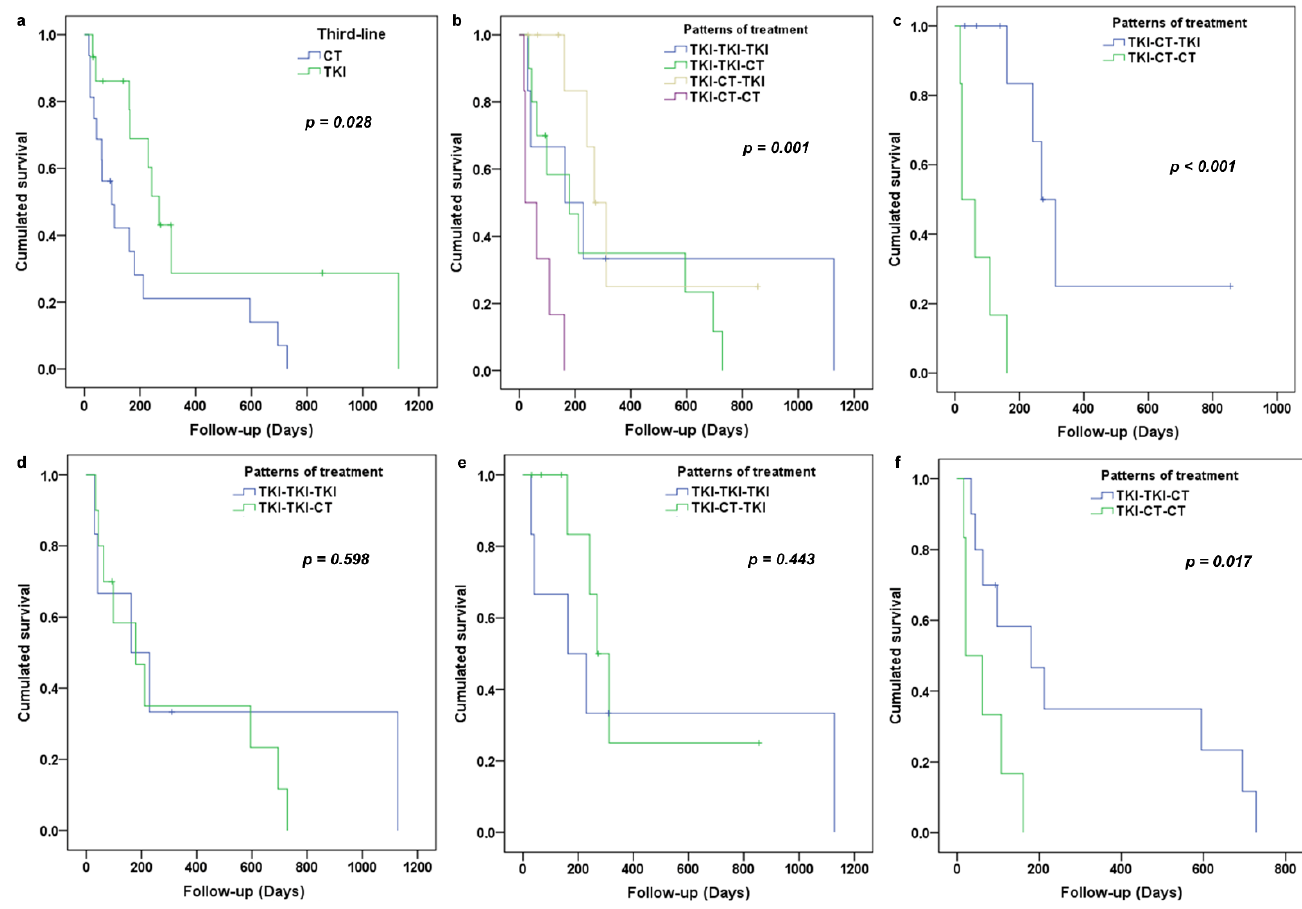
Figure 2. PFS according to the treatment received in third-line ( a ) and according to the pattern of treatment ( b ). PFS according to the choice of third-line for patient which received CT in second-line ( c ) and received TKI in second-line ( d ). ( e , f ) represent respective PFS according to choice of second-line for patient which received TKI in third-line and CT in third-line.